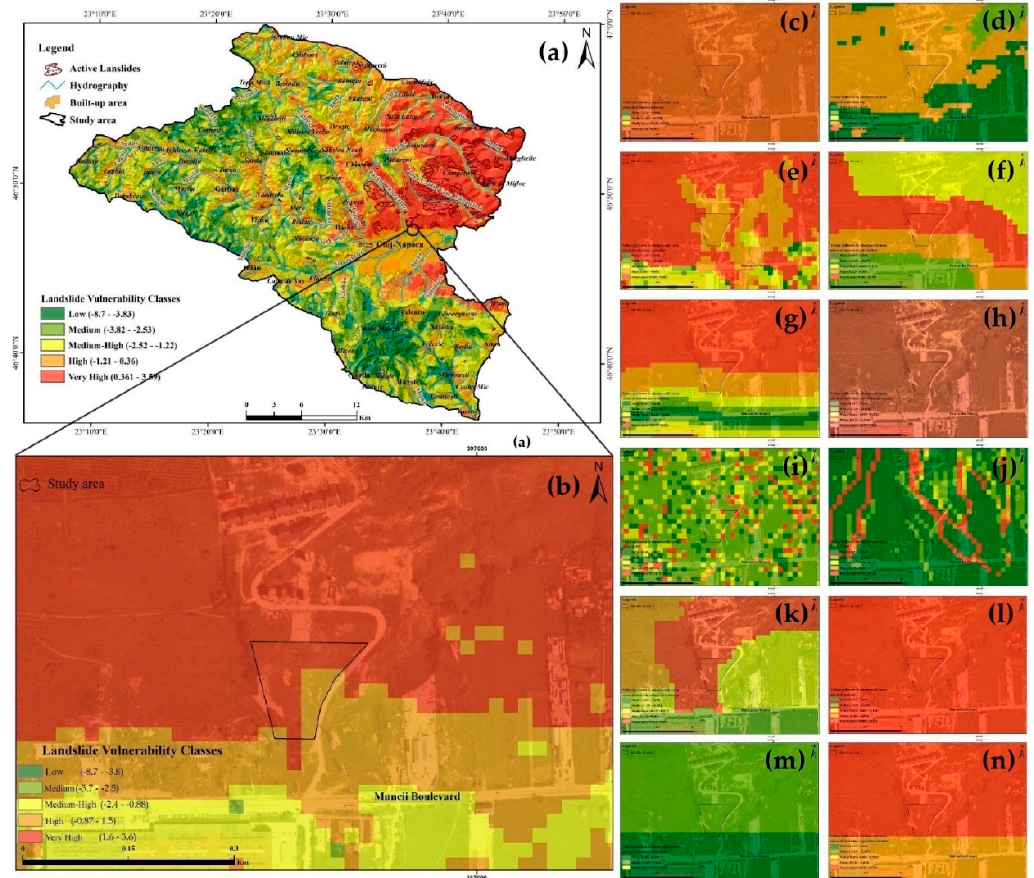
Figure 7. Map of the prior research study’s landslide susceptibility [4] ( a ) and of the study area ( b ); the twelve factors that have been examined as potential influencing factors for slope mass movement: altitude ( c ), slope ( d ), aspect ( e ), distance to settlements ( f ), roads ( g ), hydrography ( h ), wetness index ( i ), stream power index ( j ), land-use ( k ), geology ( l ), depth of fragmentation ( m ), and fragmentation density ( n ).